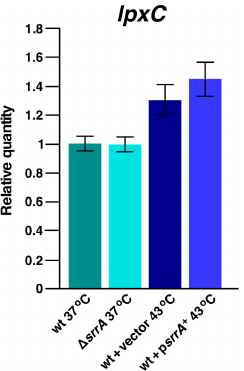
Figure 15. Transcription of the lpxC gene is not positively regulated by SrrA. q-RT-PCR analysis of mRNA extracted from wild-type bacteria, its ∆ srrA derivative and transformed with either the vector DNA alone or when the srrA gene expression is induced from the IPTG-inducible promoter present in the plasmid. Isogenic bacterial cultures were grown with or without temperature shifts at the indicated temperatures. Data presented are from RNA isolated from three biological replicates and error bars are